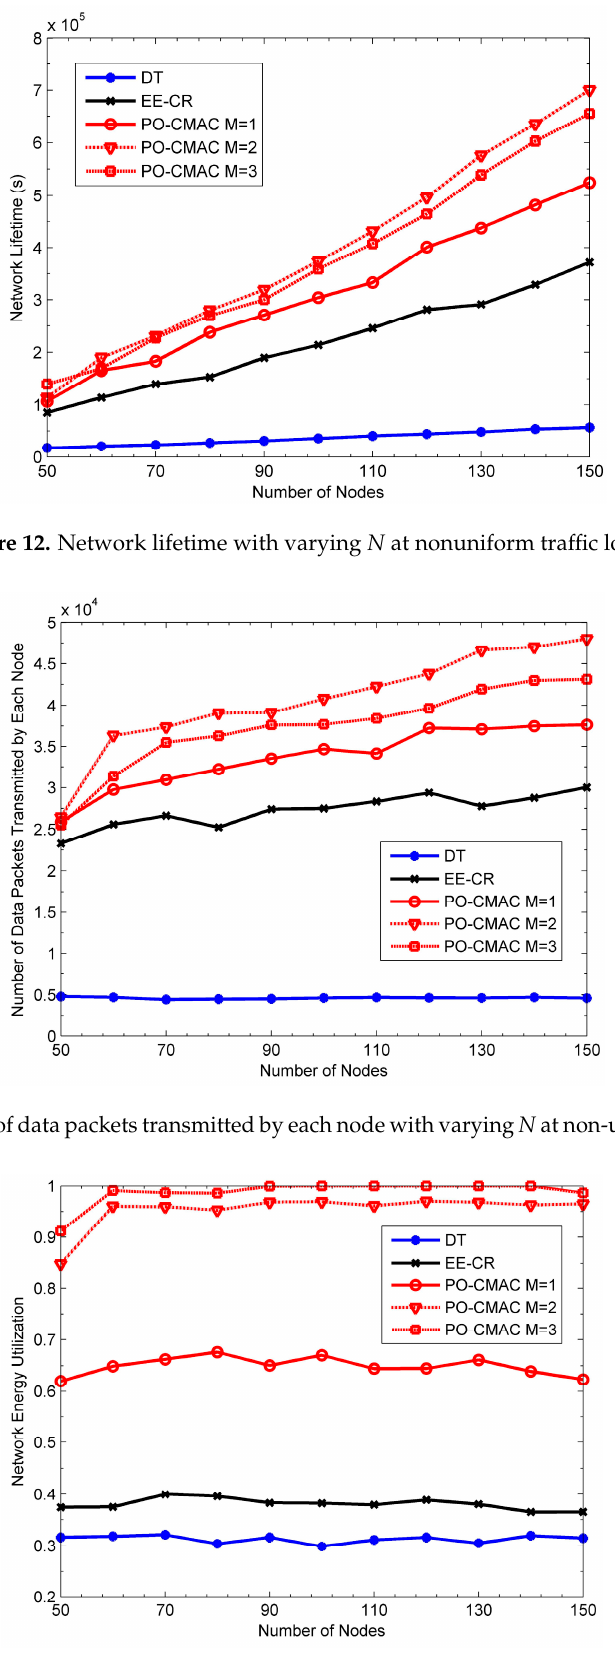
Figure 14. Network energy utilization with varying N at non-uniform traffic load.